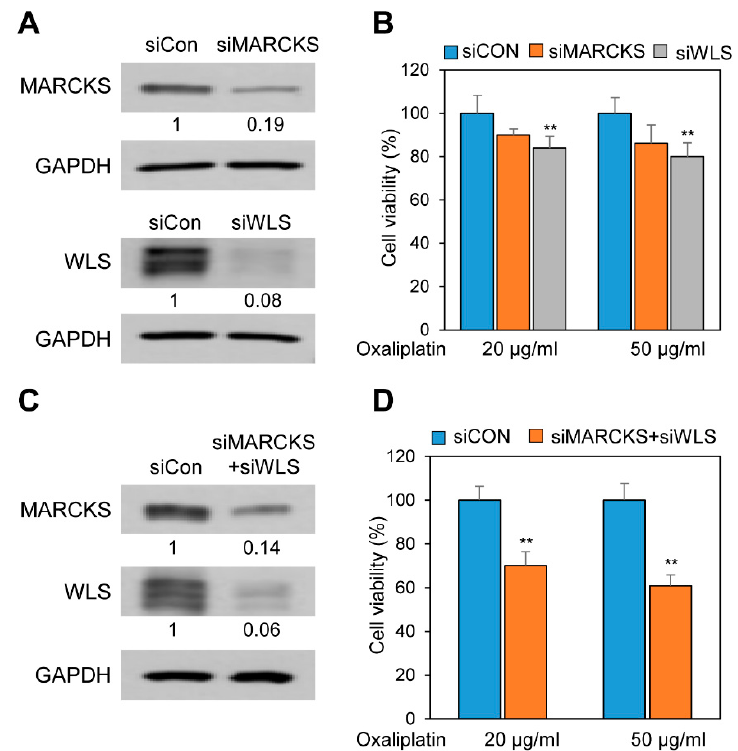
Figure 7. The inhibition of MARCKS and WLS induced PANC-1R cells to be sensitive to oxaliplatin. ( A ) The level of MARCKS or WLS in PANC-1R cell with the treatment of siMARCKS or siWLS was obtained by Western blotting. Full-length Western blot images are presented in Supplementary Figure S2. ( B ) The cell viability to oxaliplatin was analyzed by Ex-cytox in PANC-1R with knockdown of MARCKS or WLS. ( C ) The levels of MARCKS and WLS in PANC-1R cells treated with both siMARCKS and siWLS were obtained by Western blotting. Full-length Western blot images are presented in Supplementary Figure S2. ( D ) The cell viability to oxaliplatin was analyzed by Ex-cytox in PANC-1R cells treated with both siMARCKS and siWLS. ** p < 0.01.